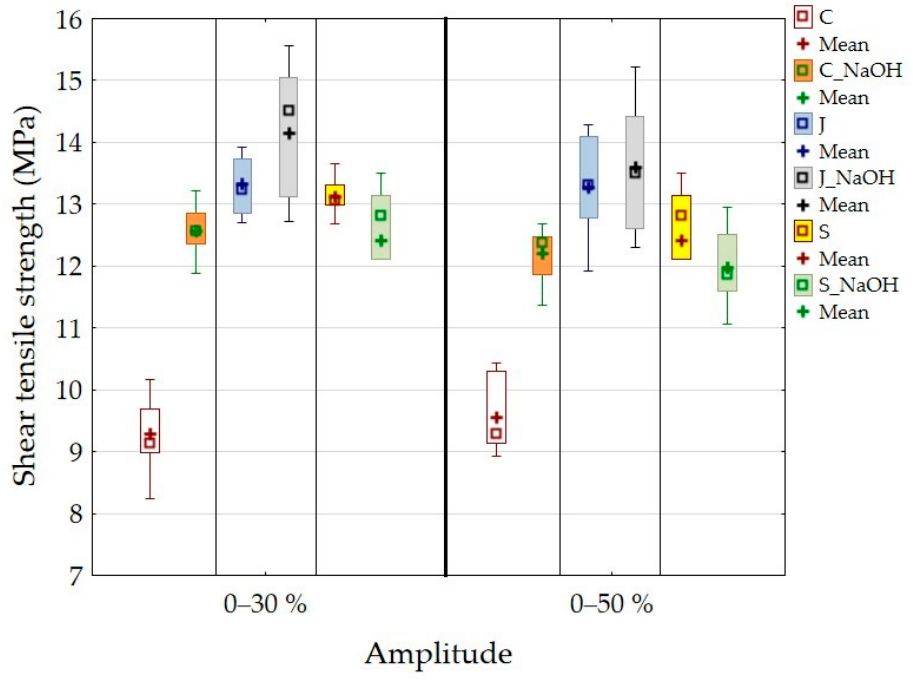
Figure 8. Strength results after cyclic loading of adhesive bonds with a composite adhesive layer.